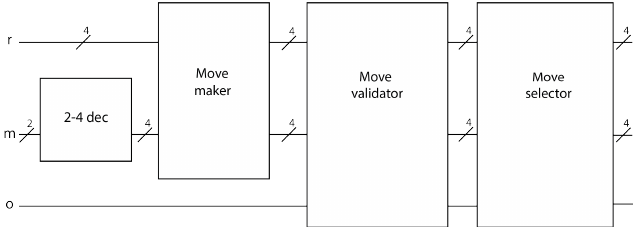
Figure 15. Block schema of the components of the M operator for the 4 × 4